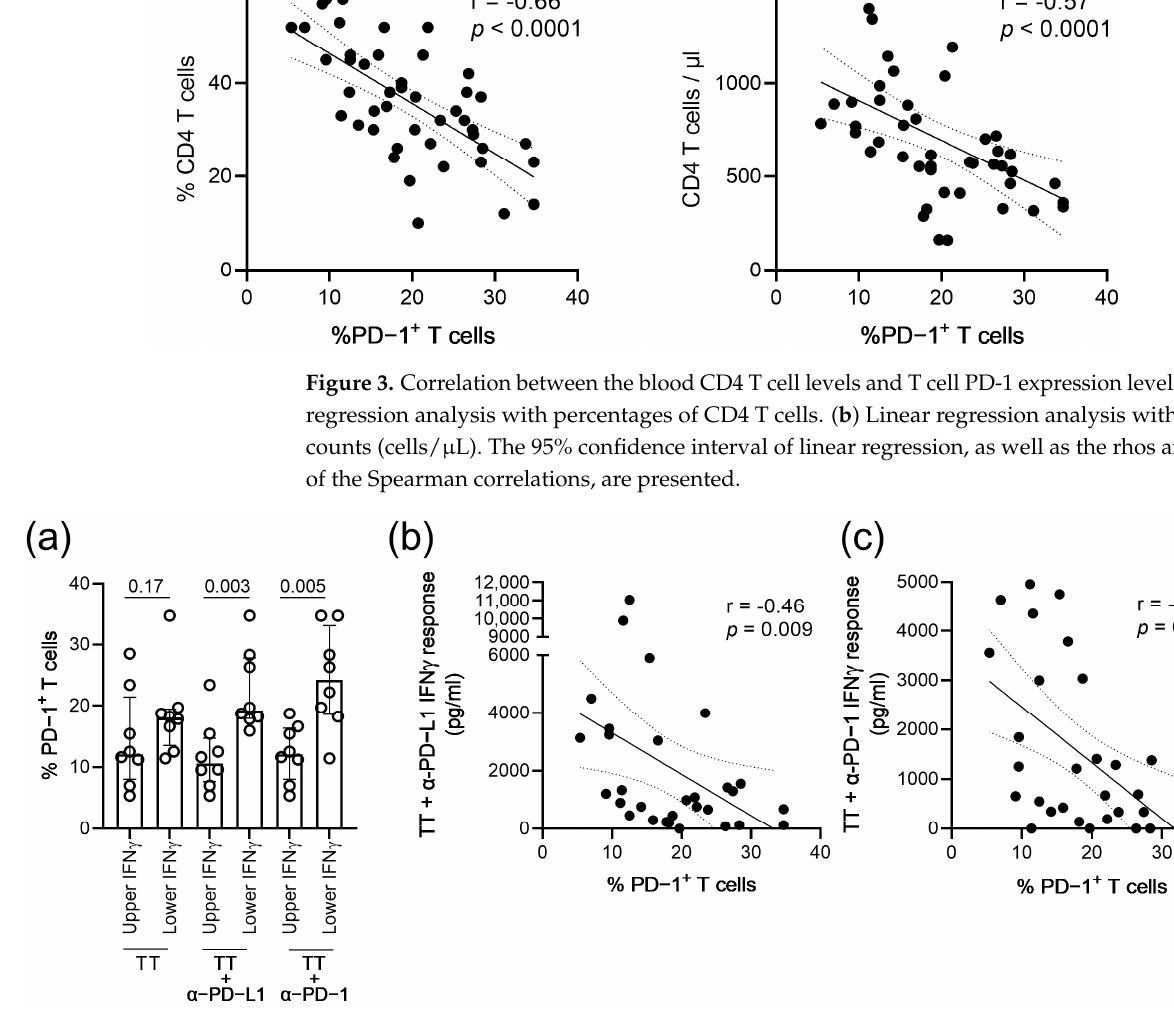
Figure 4. Association between the T cell PD-1 expression levels and TT-specific IFN γ responses in the presence of antibodies blocking the PD-1 pathway. ( a ) T cell PD-1 expression levels of the participants with upper or lower quartiles of IFN γ responses to TT alone, TT+ anti-PD-L1 (20 µ g/mL) or TT+ anti-PD-1 (40 µ g/mL). Medians, interquartile ranges and p -values of the comparison between groups using the Mann–Whitney test are presented. ( b ) Correlation analysis between the T cell PD-1 expression levels and IFN γ responses to TT+ anti-PD-L1 (20 µ g/mL) of the 30 TT-seropositive HIV-infected persons. ( c ) Correlation analysis between the T cell PD-1 expression levels and IFN γ responses to TT+ anti-PD-1 (40 µ g/mL). The 95% confidence interval of the linear regression, as well as the rhos and p -values of the Spearman correlations, are presented.